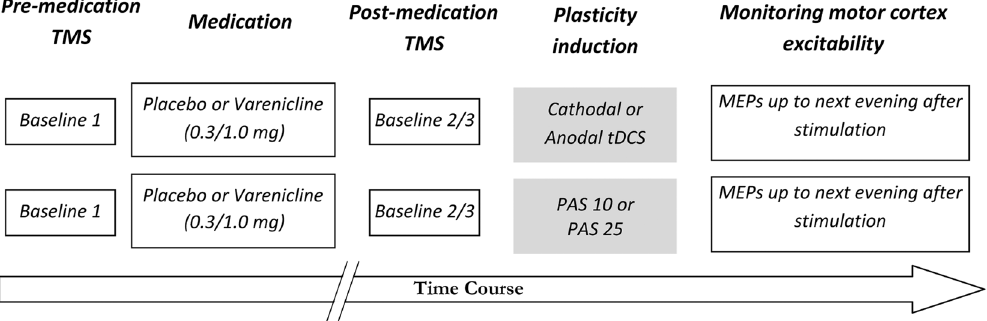
Figure 1. Course of the study. Participants were not allowed to smoke 10 h before and during the experimental session. In the beginning of each session, 25 baseline single pulse MEPs were recorded at an intensity to elicit MEPs with peak-to-peak amplitudes of on average ~1 mV before administration of varenicline (0.3 or 1 mg) or placebo medication. Three hours later, a second baseline was recorded to explore the effect of medication on cortical excitability, and the stimulation intensity was adjusted, if necessary (third baseline). Next, tDCS (cathodal or anodal) or PAS (PAS10 or PAS25) was administered and blocks of 25 MEPs were recorded at time points of 0, 5, 10, 15, 20, 25, 30, 60, 90 and 120 minutes after plasticity induction. Further TMS measurements were conducted in the evening of the same day (SE), morning (at ~9:00 AM, NM), noon (at ~12:00 PM, NN) and evening (at ~6:00 PM, NE) of the second